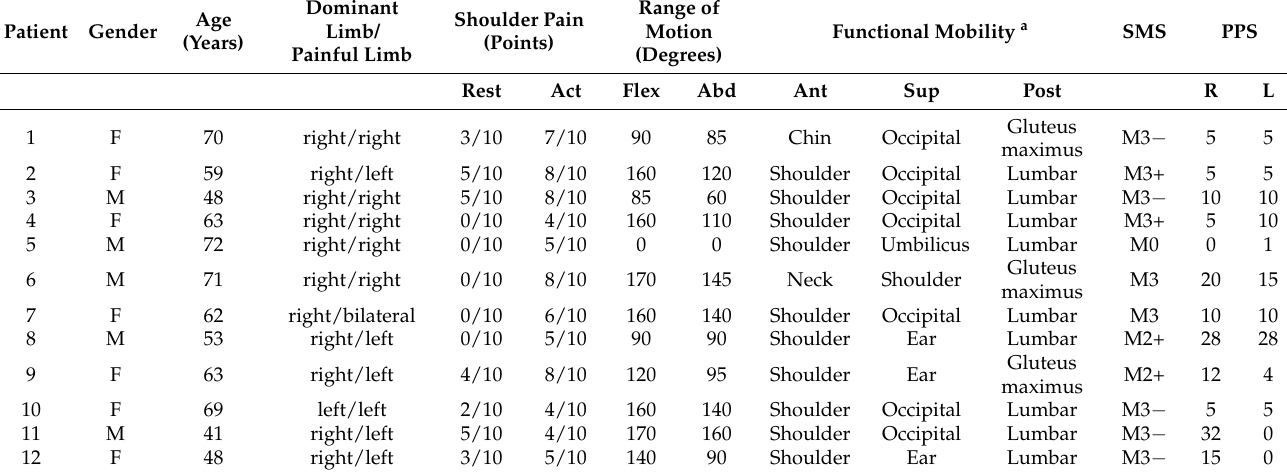
Table 2. Patient characteristics and shoulder evaluation